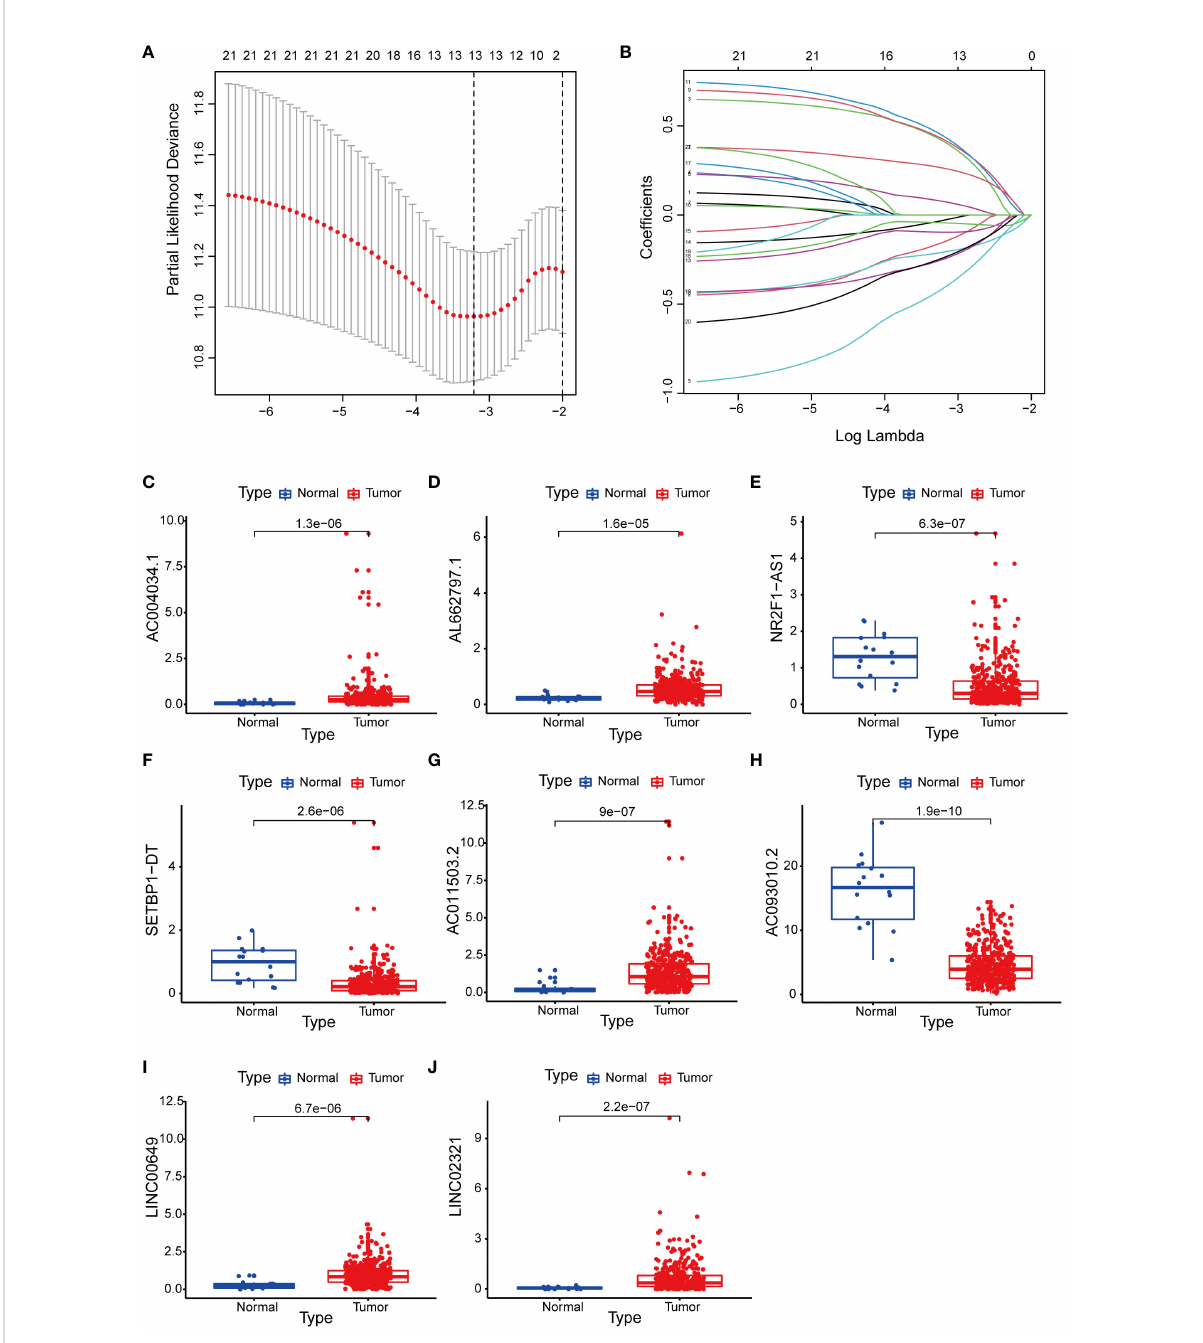
FIGURE 2 Construction of a basement membrane-associated lncRNA risk model. (A) The LASSO coef fi cient pro fi le of 8 differential basement membrane- associated lncRNAs. (B) Variable cross-validation in LASSO regression. Expression of 8 lncRNAs (C) AC004034.1 (D) AL662797.1 (E) NR2F1-AS1 (F) SETBP1-DT (G) AC011503.2 (H) AC093010.2 (I) LINC00649 (J) LINC02321 in bladder cancer and adjacent paracancerous tissues from the TCGA